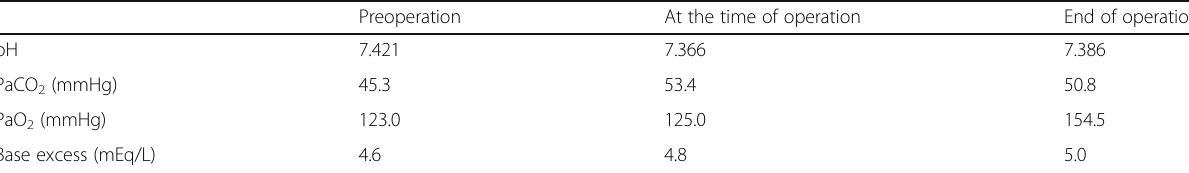
Table 2 Preoperative and intraoperative arterial blood gas data Preoperation At the time of